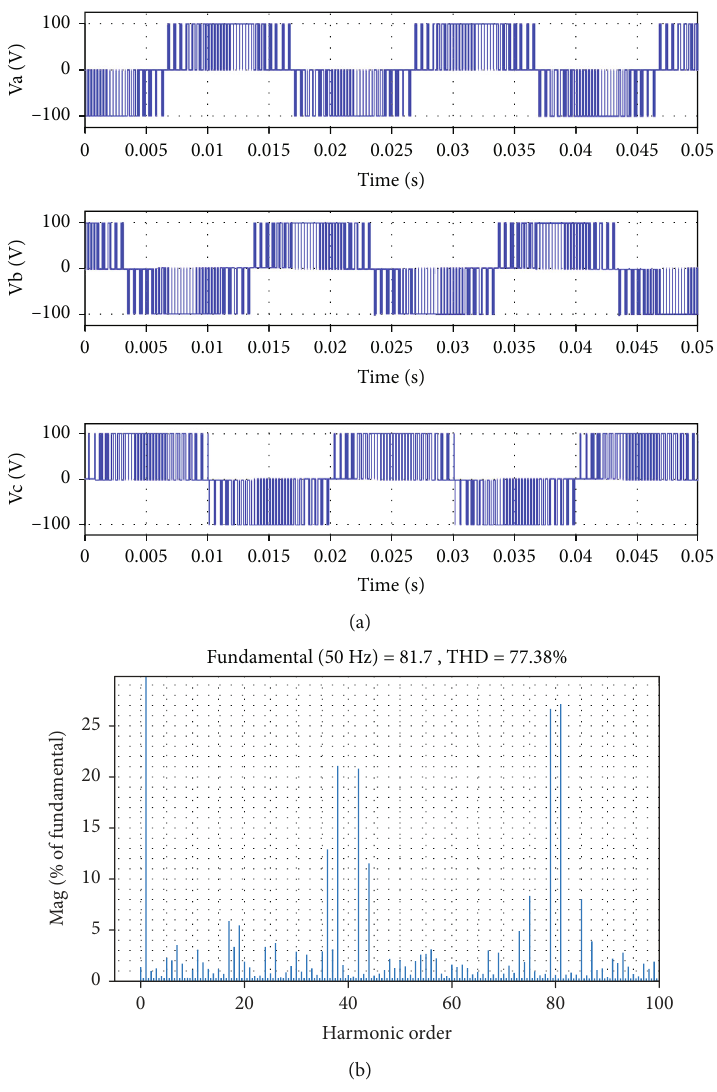
Figure 8: Line voltages ( V